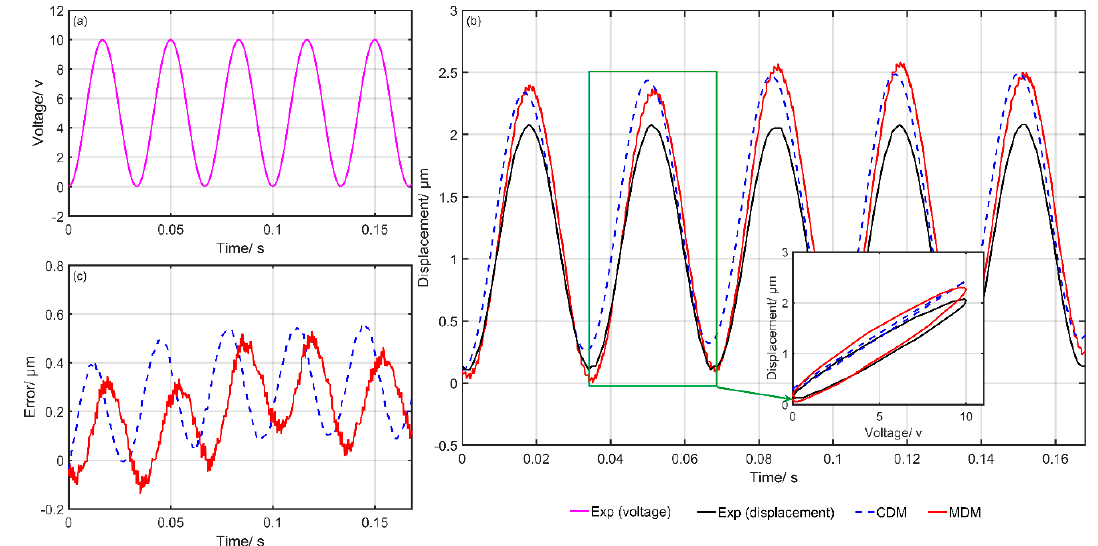
Figure 10. Exp5: Comparison of the experimental and simulation results of the CDM and MDM under u 5 ( t ) = 5sin ( 2 π · 30 t )+ 5: ( a ) Time histories of input voltage, ( b ) time histories of output displacements and ( c ) time histories of errors of the CDM and MDM.